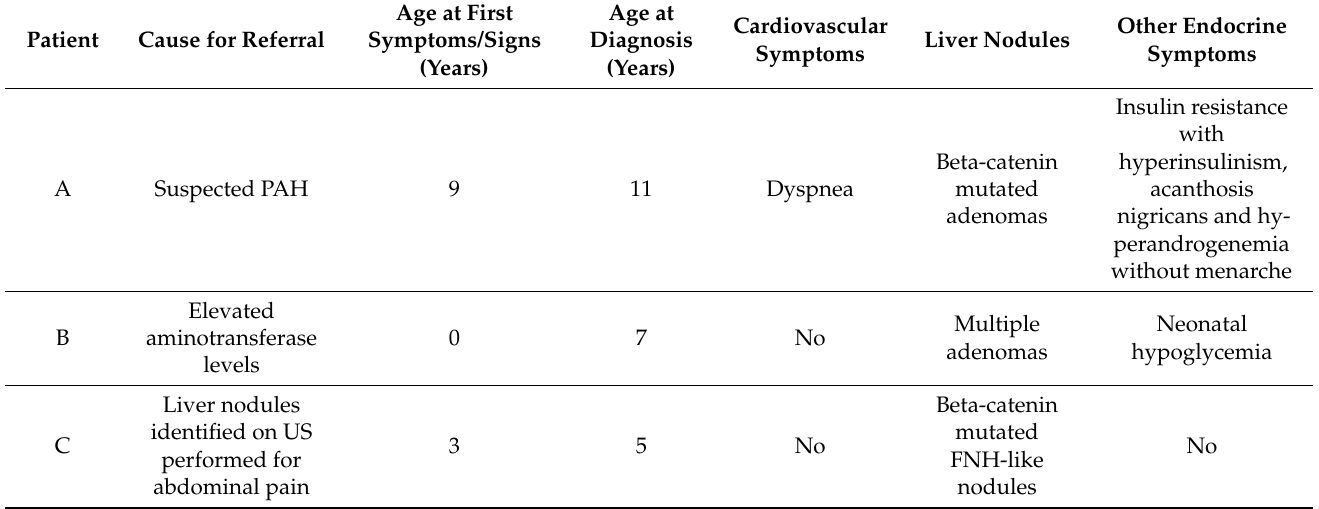
Table 1. Summary of three cases of congenital portosystemic shunts presenting with tall stature (>percentile 97). PAH = pulmonary arterial hypertension; US = ultrasound; FNH = focal nodu- lar